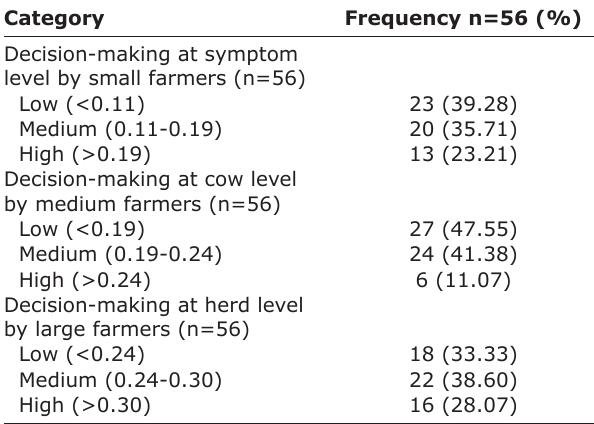
Table-7: Distribution of farmers as per level of decision-making among different farmer categories